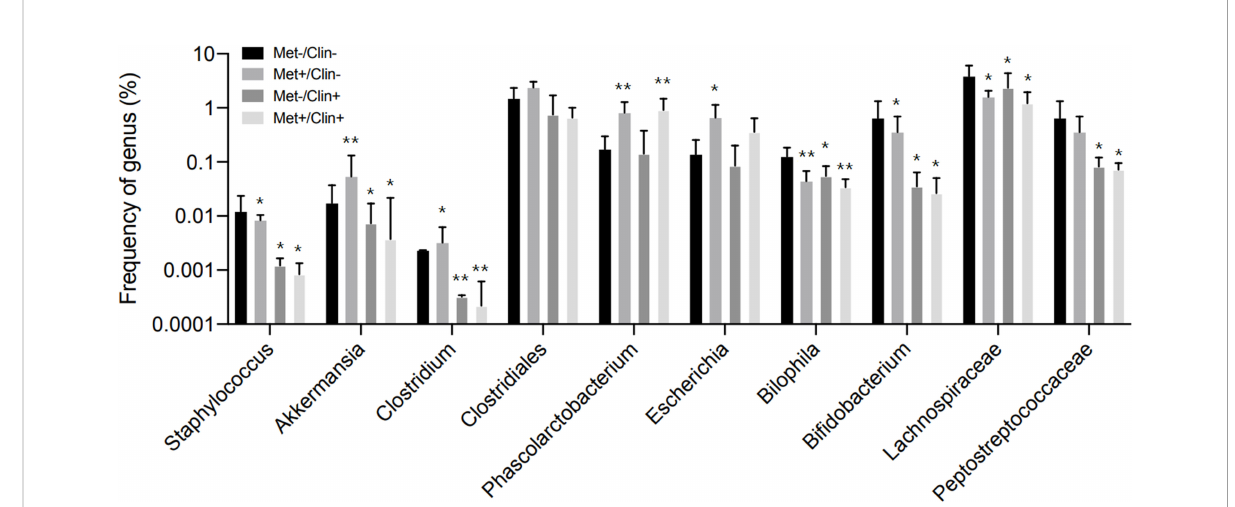
FIGURE 5 Frequency of genus in experiment A. Met, metformin; Clin, clindamycin. *Compared with the Met-/Clin- group, P <0.05; **Compared with the Met-/Clin- group, P